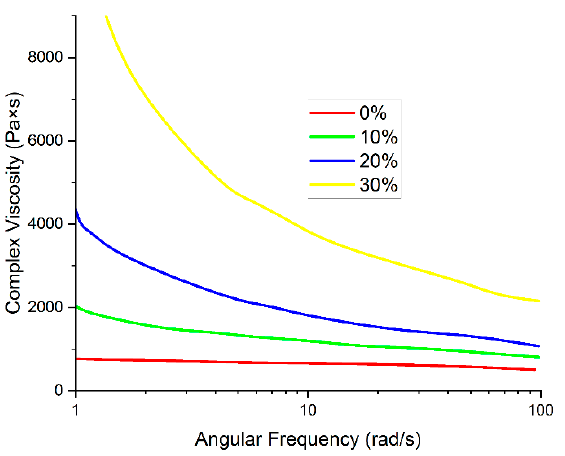
Figure 3. Dependence of melt viscosity on angular frequency for R-BAPB modified with CF.